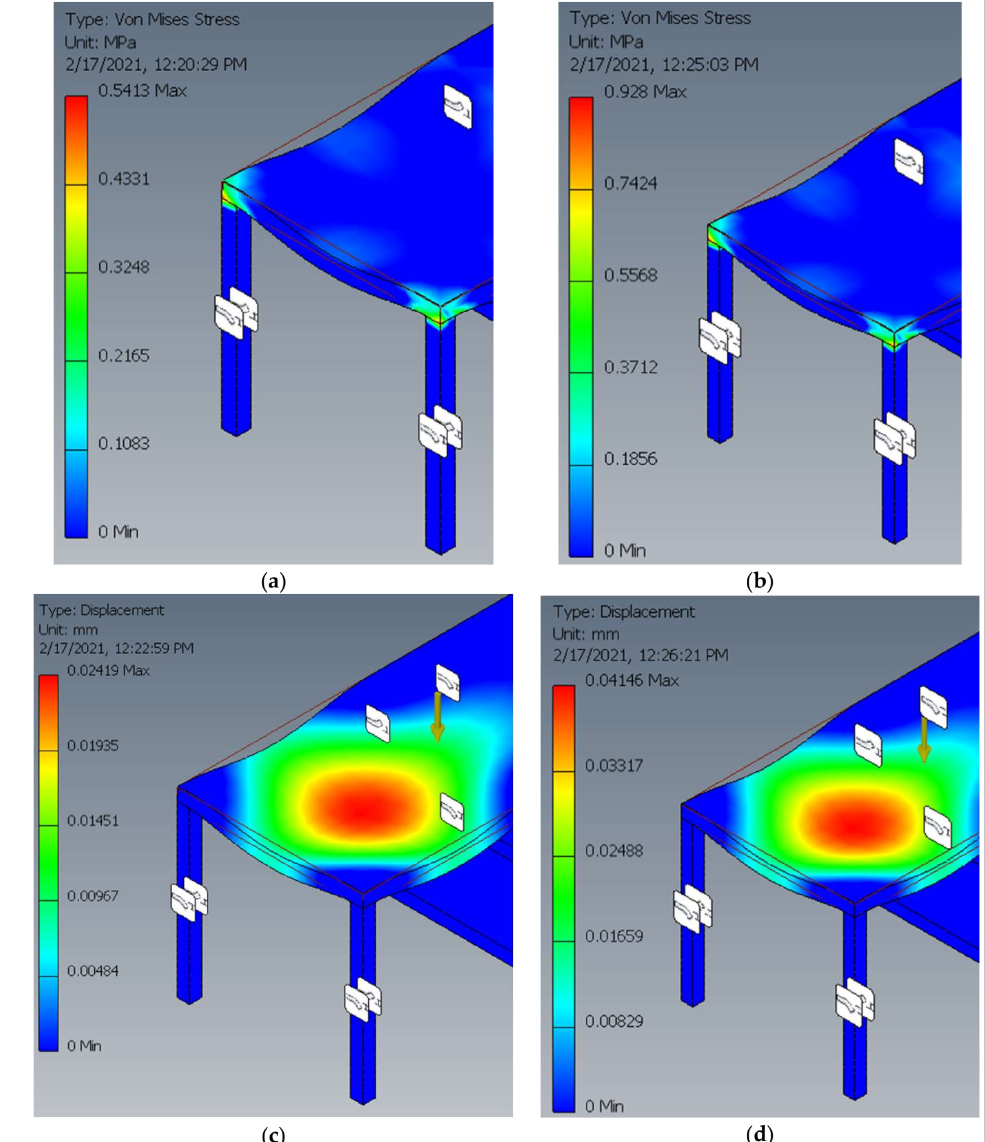
Figure 7. Von Mises stress and displacement simulation results for invention in table-transformed state when applying weights of 70 kg and 120 kg. ( a ) Von Mises stress simulation for 70 kg, ( b ) Von Mises stress simulation for 120 kg, ( c ) Displacement simulation for 70 kg, ( d ) Displacement simulation for 120